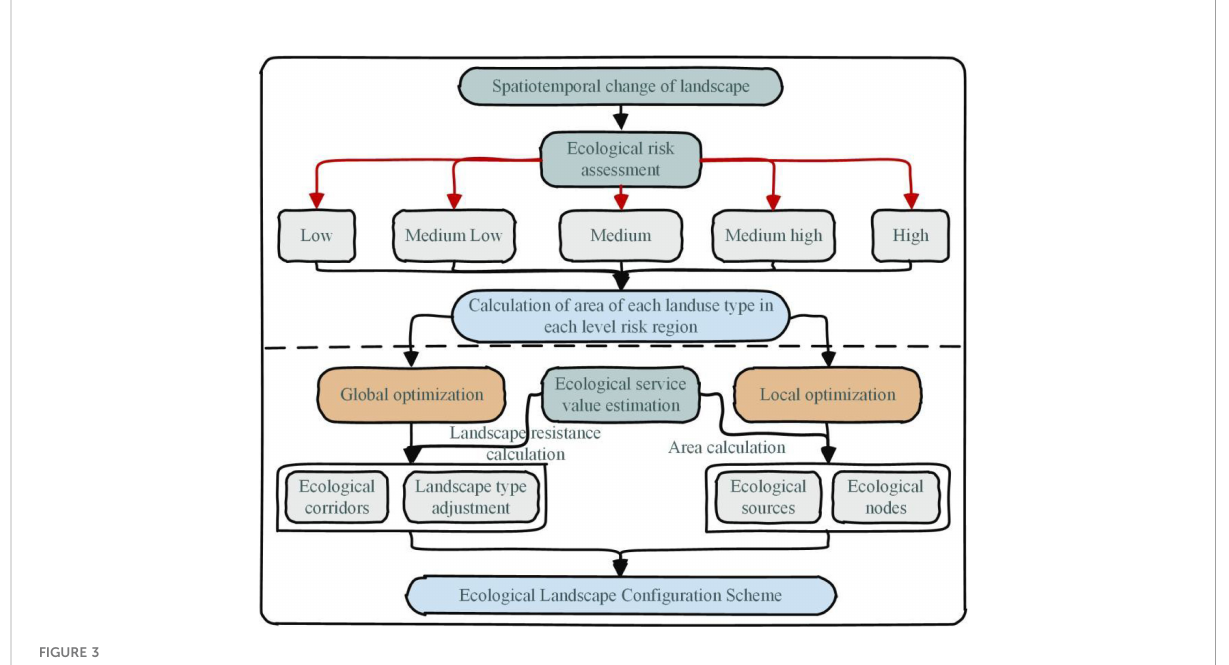
FIGURE 3 Method of landscape pattern optimization of the coastal city of this